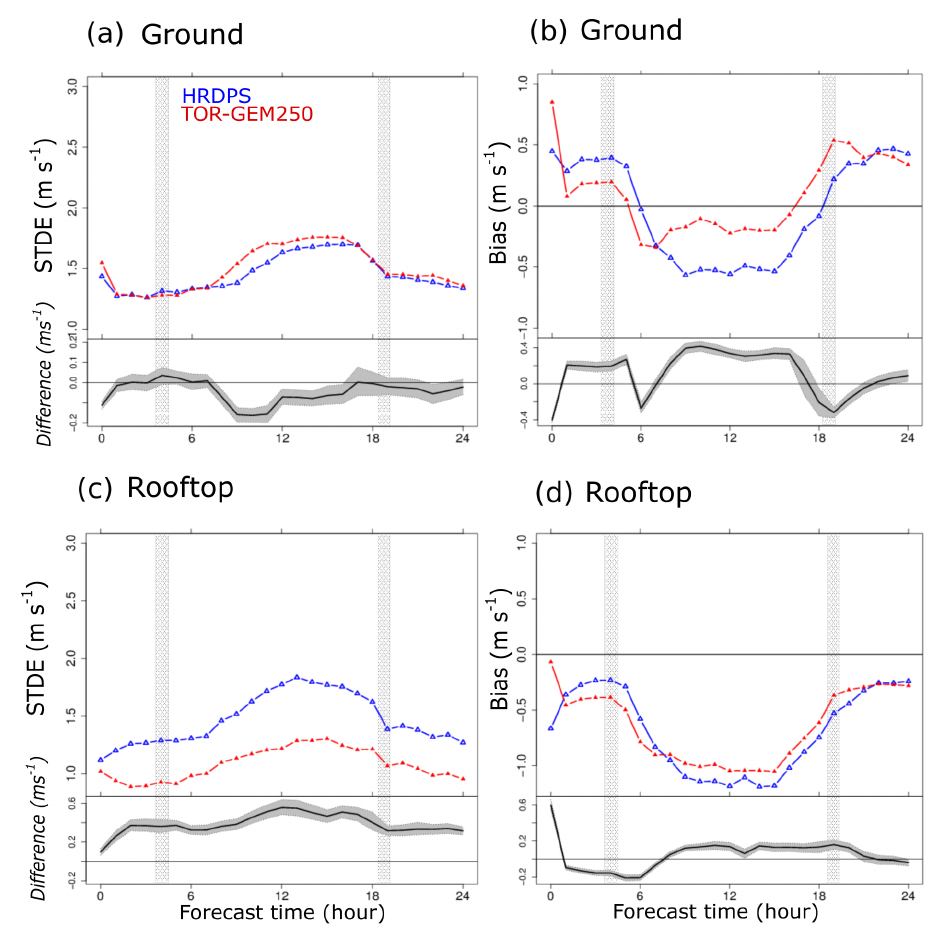
Figure 16. Same as Figure 12 but for the wind speed (m s − 1 ). ( a ) STDE and ( b ) Bias for the stations with 10-m wind measurements above the ground, ( c ) STDE and ( d ) Bias for the rooftop stations with model height corrections (see details in the